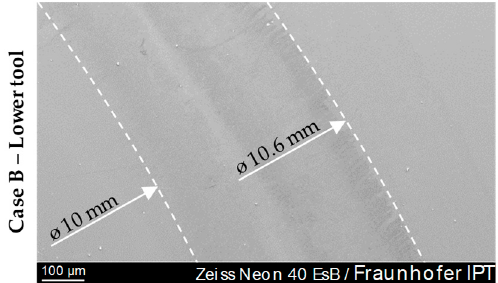
Figure 18. Alterations in the glass transition zone of Case B moulding tools.